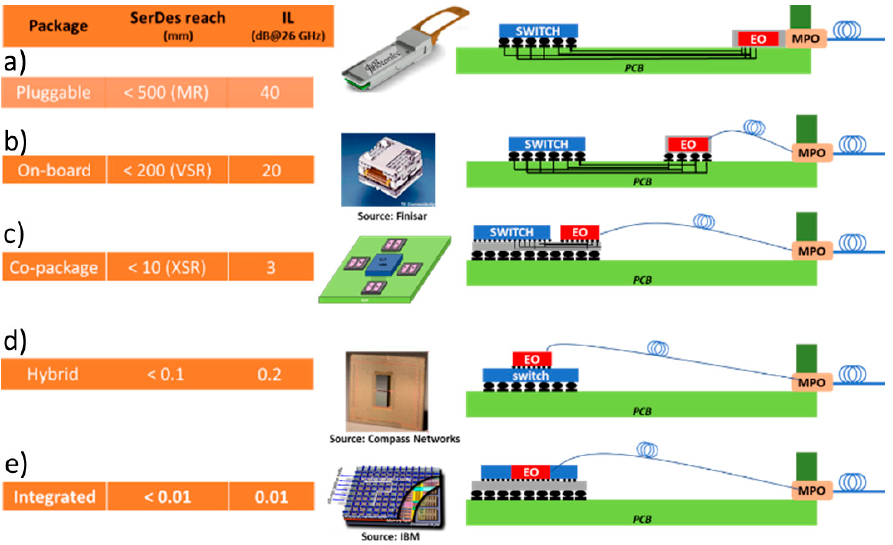
Figure 1. The progress of integrating the optical interconnect with the switch